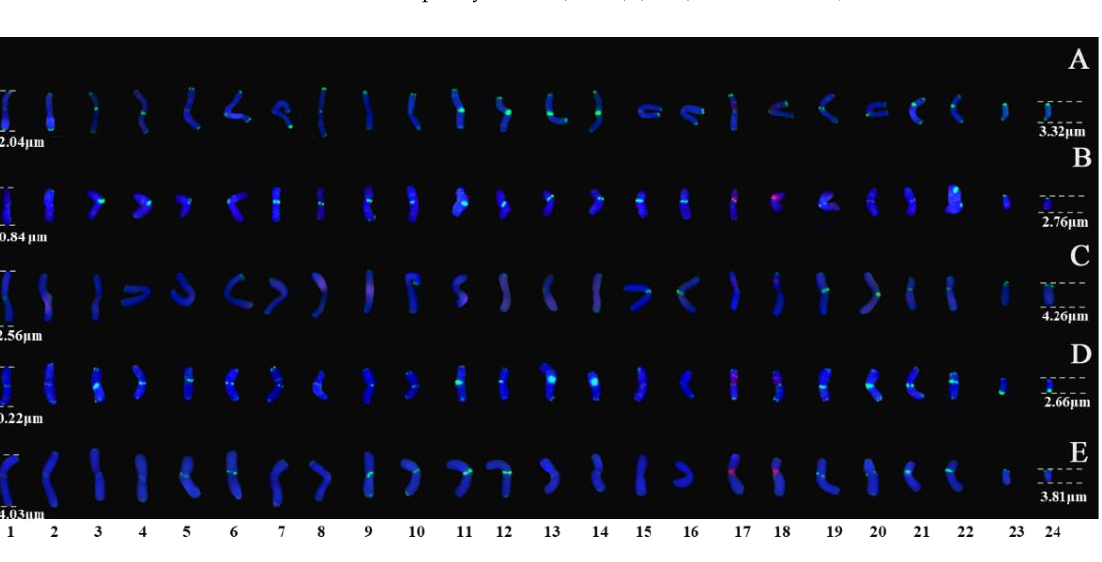
Figure 2. Visualization of the mitotic metaphase chromosomes of T. wallichiana ( A ), T. × media ( B ), T. yunnanensis ( C ), T. cuspidate ( D ), and T. wallichiana var. mairei ( E ) after fluorescence in situ hybridization (FISH). The first probe of (AG 3 T 3 ) 3 was labelled with 6-carboxyfluorescein (FAM) (green); the second probe of 5S rDNA was labelled with 6-carboxytetramethylrhodamine (TAMRA) (red). Chromosomes probed with 5 (cid:48) -TAMRA-labelled 5S rDNA (red fluorescence, arrow) are shown in ( A – E ). The concentration of all the probes was 10 µ M. All the chromosomes were counterstained with 4,6-diamidino-2-phenylindole (DAPI) (blue). Scale bar = 5 µm.